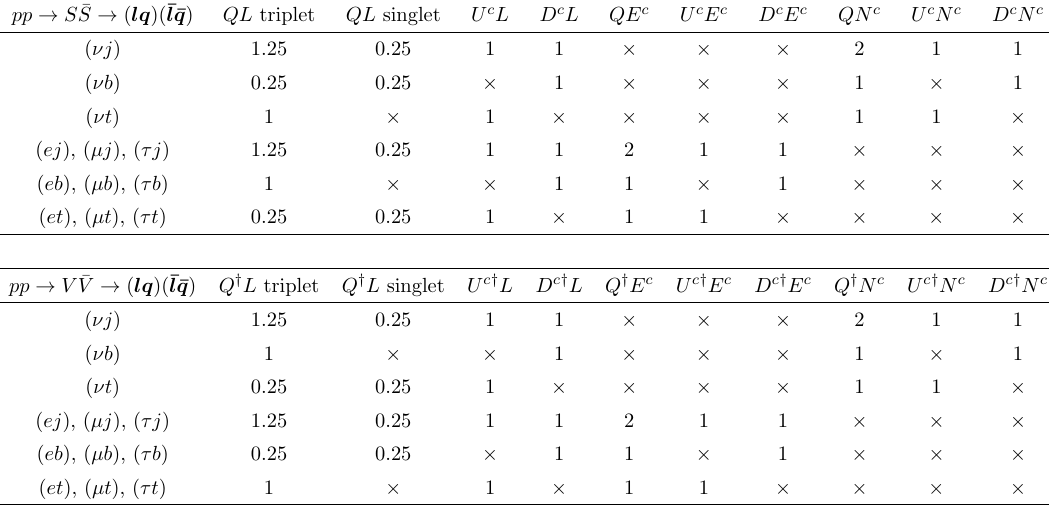
Table 1 . ( Upper table ) (cid:22) -factors for production and decay (cid:27) ( pp ! S (cid:22) S ! ( lq )((cid:22) l (cid:22) q )) in di(cid:11)erent scalar MLQ models. Rows correspond to di(cid:11)erent (cid:12)nal states whereas columns correspond to di(cid:11)erent MLQ models. For example, the (cid:12)rst row of the (cid:12)rst column corresponds to pair production of a scalar LQ which decays to ( (cid:23)j ) via a coupling in which Q and L are contracted into an isospin triplet. For any (cid:12)nal state ( ql )( ql ), the (cid:22) -factor is the factor which multiplies the (cid:12)ducial cross section (cid:27) S in (cid:12)gure 4 to account for multiplicities and branching fractions. MLQs which couple to SU(2) weak -singlet fermions always have (cid:22) = 1. A \ (cid:2) " entry indicates that MLQ model does not contribute to the (cid:12)nal state. ( Lower table ) (cid:22) -factors for the vector leptoquark V . Comparing to the scalar case, di(cid:11)erences exist only in the (cid:12)rst two columns. Note that the (cid:22) -factors for scalar MLQs decaying to ( (cid:23)t ) ; ( eb ) ; ( (cid:22)b ) ; ( (cid:28)b ) and vector MLQs ( (cid:23)b ) ; ( et ) ; ( (cid:22)t ) ; ( (cid:28)t ) are equal to 1 irrespective of MLQ